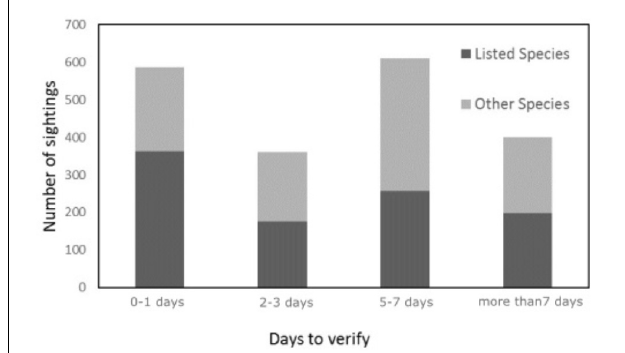
FIGURE 5 | Number of days taken to verify species identification after an observation is submitted to Redmap Australia via the website or smartphone app. Note, ‘other species’ are species not ‘listed’ as Redmap species, and therefore do not have existing database links directly to expert scientists, instead being directed to experts manually via the regional